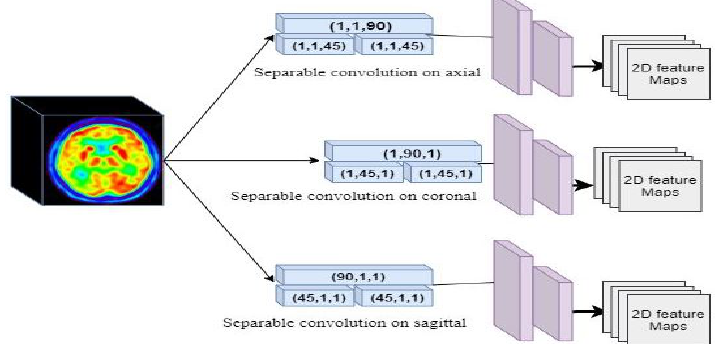
Figure 2. Configuration of the Elicit Network for projection the features in